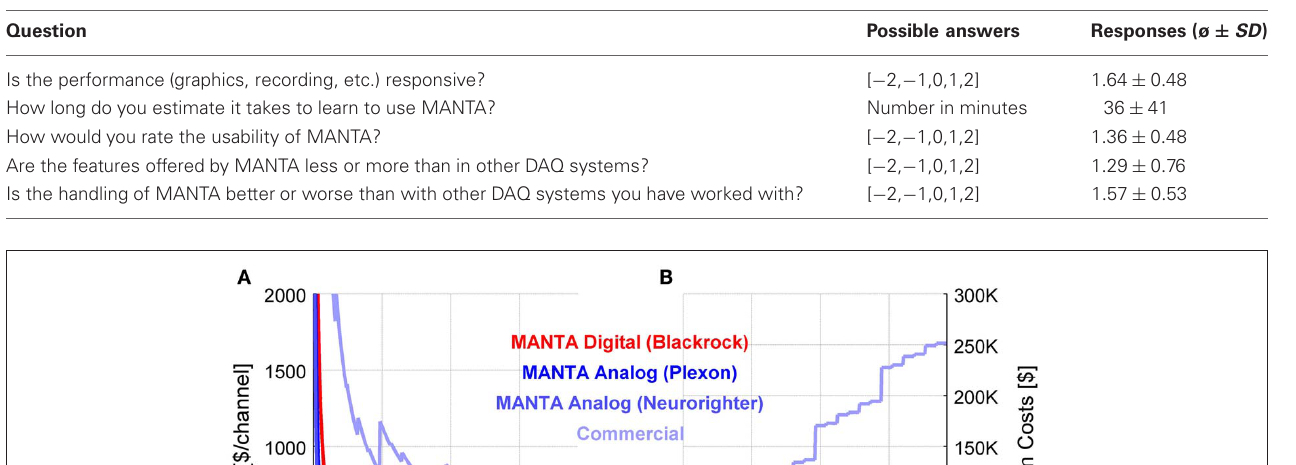
FIGURE 6 | Comparison of costs per channel or system costs for analog and digital systems. Acquiring neurophysiological data from large electrode arrays necessitates matched numbers of channels in the DAQ system. A MANTA based DAQ system can be built with hundreds of channels at moderate costs, since per channel costs are < $100/channel (A) and system costs even for a 400 channel digital system (red) can stay below $50K (B) .